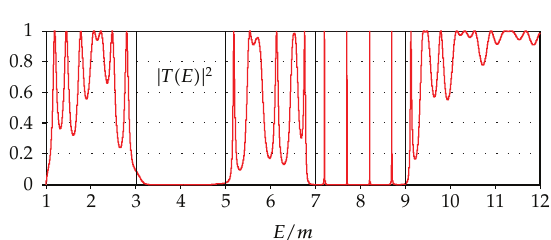
Figure 2: The transmission coe ffi cient as a function of energy associated with the potential configuration of Figure 1 for V (cid:2) (cid:9) 8 m , V − (cid:9) 4 m , a (cid:2) (cid:9) 3 /m , and 2 a − (cid:9) 5 /m . Evident are the three subbarrier transmission- resonance regions. The lowest two are within the two Klein energy zones and the highest one with sharp resonances is bounded within the energy range V (cid:2) ± m